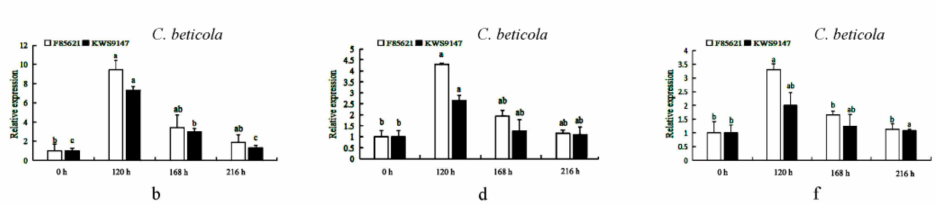
Figure 10. The relative expression of BvBTB1 , BvBTB2 , and BvBTB3 after high and low spore concentrations of C. beticola infection at different times in roots in the resistant material ‘F85621’ and susceptible material ‘KWS9147’. X-axial represents the times of C. beticola infection in sugar beet, while Y-axial represents the relative expression of BvBTB in sugar beet materials ‘F85621’ and ’KWS9147’ on C. beticola infection. ( a ) The relative expression of BvBTB1 in roots at 0, 120, 168, 216 h in sugar beet resistant material ‘F85621’ and susceptible material ‘KWS9147’ after low spore concentrations of C. beticola with 7 × 10 6 spores/mL infection. ( b ) The relative expression of BvBTB1 in roots at 0, 120, 168, 216 h in sugar beet resistant material ‘F85621’ and susceptible material ‘KWS9147’ after high spore concentrations of C. beticola with 16 × 10 6 spores/mL infection. ( c ) The relative expression of BvBTB2 in roots at 0, 120, 168, 216 h in sugar beet resistant material ‘F85621’ and susceptible material ‘KWS9147’ after low spore concentrations of C. beticola with 7 × 10 6 spores/mL infection. ( d ) The relative expression of BvBTB2 in roots at 0, 120, 168, 216 h in sugar beet resistant material ‘F85621’ and susceptible material ‘KWS9147’ after high spore concentrations of C. beticola with 16 × 10 6 spores/mL infection. ( e ) The relative expression of BvBTB3 in roots at 0, 120, 168, 216 h in sugar beet resistant material ‘F85621’ and susceptible material ‘KWS9147’ after low spore concentrations of C. beticola with 7 × 10 6 spores/mL infection. ( f ) The relative expression of BvBTB3 in roots at 0, 120, 168, 216 h in sugar beet resistant material ‘F85621’ and susceptible material ‘KWS9147’ after high spore concentrations of C. beticola with 16 × 10 6 spores/mL infection. The housekeeping gene of beet Gapdh was used as an internal control to normalize the data. The experiment was performed on three biological replicates, each with three technical replicates, and was statistically analyzed using